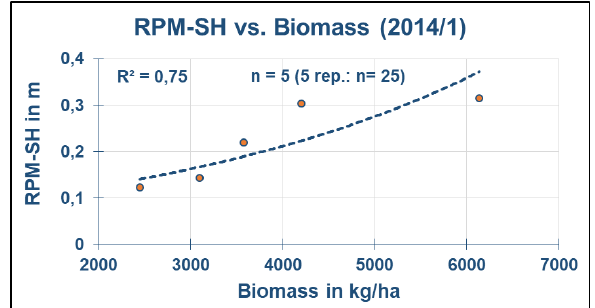
Figure 7. Relationship of RPM-SH and dry biomass